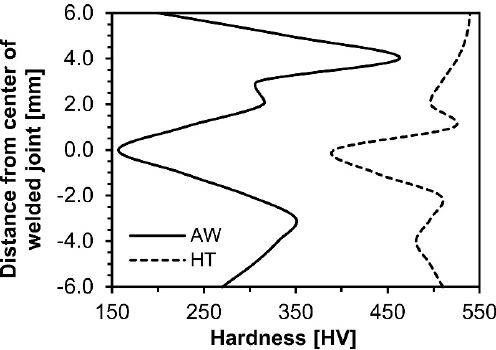
Figure 6. Hardness distribution in the welded joint of Hardox 600 along line 3 shown in Figure 2b: